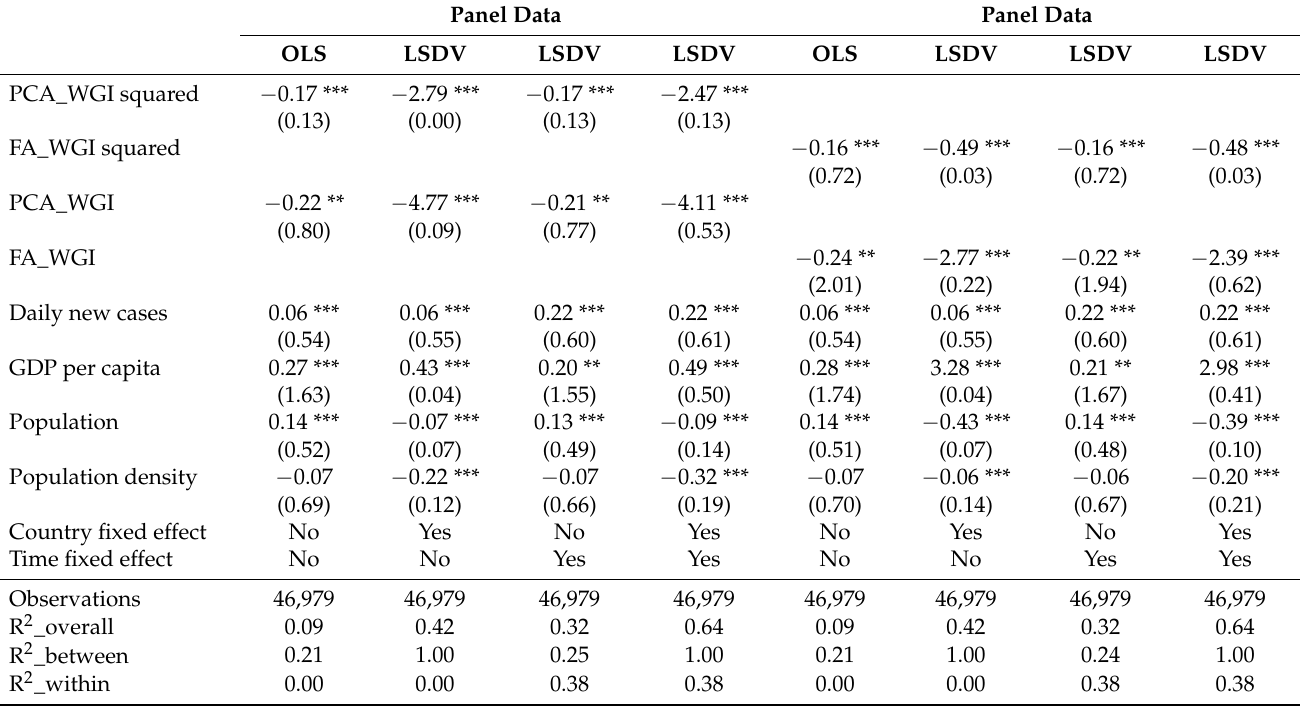
Table 6. Robustness checks: new overall governance indices. Panel Data Panel Data